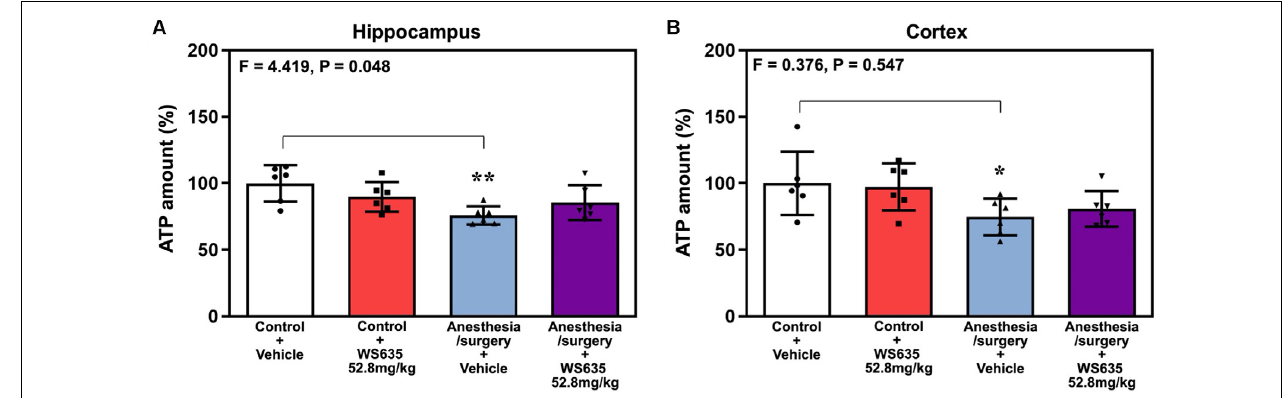
FIGURE 7 | Effects of WS635 on the anesthesia/surgery-induced changes in ATP amounts in the hippocampus and cortex of mice. Effects of WS365 (52.8 mg/kg) and vehicle (DMSO) on the anesthesia/surgery-induced changes in the amounts of ATP in the hippocampus (A) and cortex (B) of the mice immediately after the anesthesia/surgery. N = 6 mice in each group, * P < 0.05; ** P < 0.01. Two-way ANOVA with the post hoc test (Bonferroni correction) was used. P values refer to the difference among different conditions on the amounts of ATP. DMSO, dimethyl